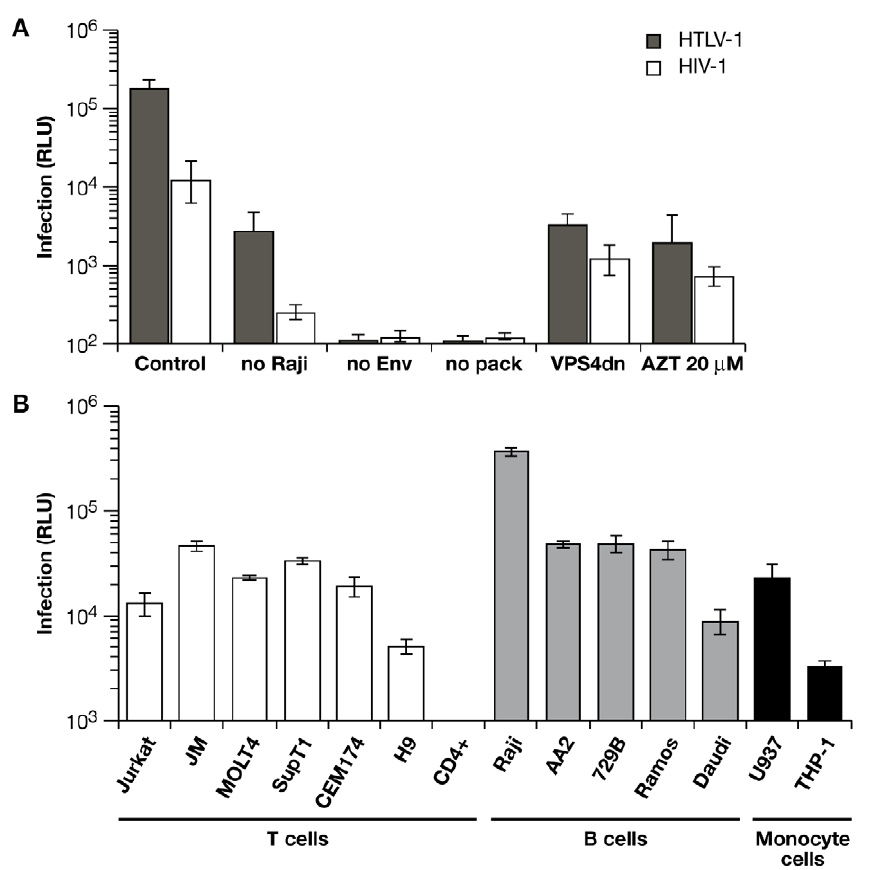
Figure 2. Characteristics of the replication dependent vectors in coculture infections. ( A ) HTLV1-inLuc and HIV1-inLuc vectors were transfected into Jurkat cells with respective packaging vectors and Env expression plasmids; transfected Jurkat cells were combined with an equal number of Raji/CD4 cells 24 h later. Infection is expressed as relative light units (RLU) of luciferase activity, measured 48 h after cell mixing. Coculture of Raji/CD4 cells with Jurkat cells transfected with wild type vectors is designated as control. The level of infection between Jurkat cells was determined in cultures without Raji/CD4 cells (no Raji). In other cocultures, Jurkat cells transfected with reporter vectors but without Env-expression plasmid (no Env) or without packaging plasmid (no pack) produced no Luc activity above background. Cotransfection of the viral vectors with a dominant-negative VPS4A plasmid (VPSdn), which inhibits virus budding, or addition of the reverse transcriptase inhibitor azidotimidine (AZT 20 m m) inhibited Luc transduction. ( B ) Jurkat cells were transfected with HTLV-1 packaging plasmid and HTLV1-inLuc reporter vector and then incubated with an equal number of the indicated cells. Luc activity in the target cells was assayed 48 h after cell mixing. Luc activity was not detected in activated human CD4 + T cells from different donors in repeated experiments. Graphs represent the mean of at least three independent experiments with error bars indicating standard deviations.